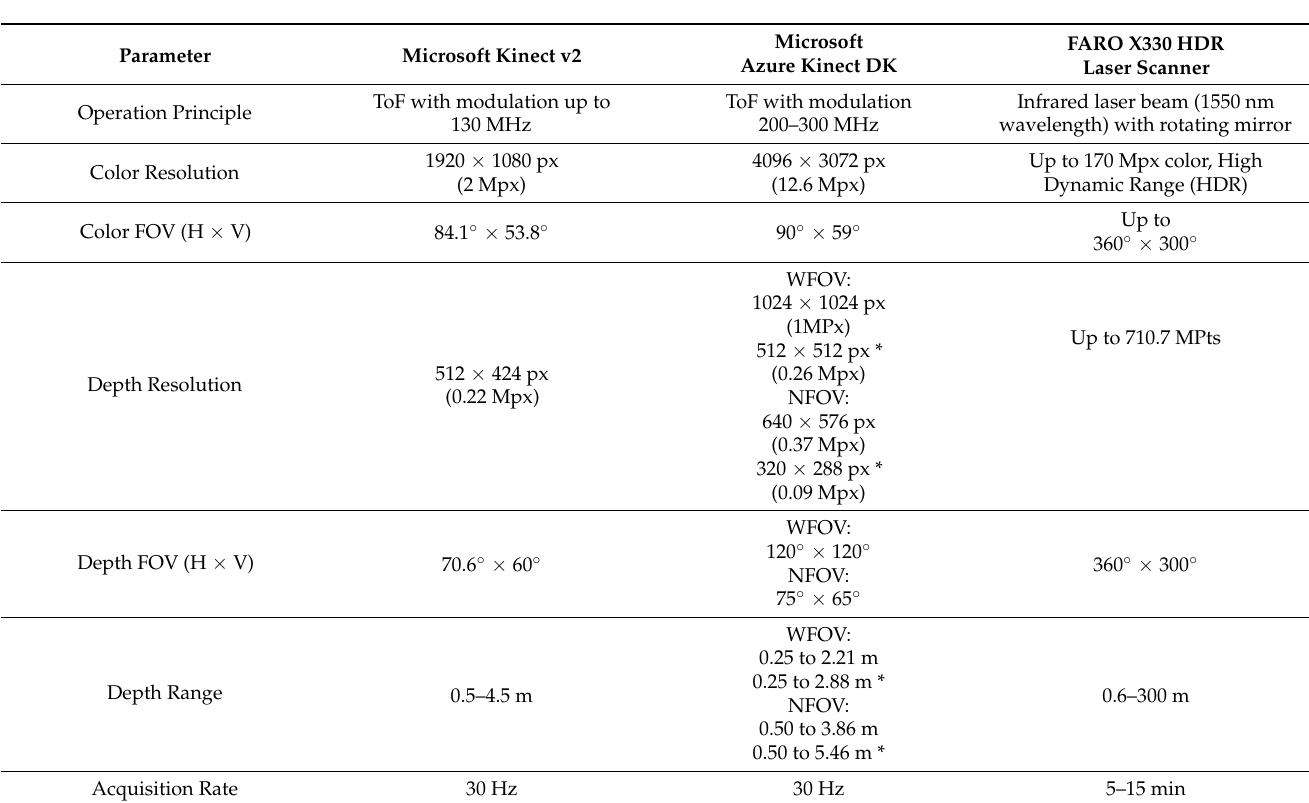
Table 1. Comparison of the performance characteristics of the three systems: Microsoft Kinect v2, Microsoft Azure Kinect DK, and the FARO X330 HDR laser scanner. An asterisk (*) indicates binned depth